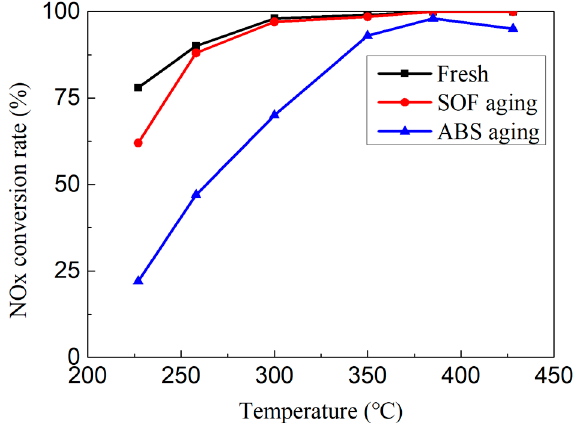
Figure 12. Evaluation of the performance of catalysts aged by SOF and ABS at 250 °C for 10